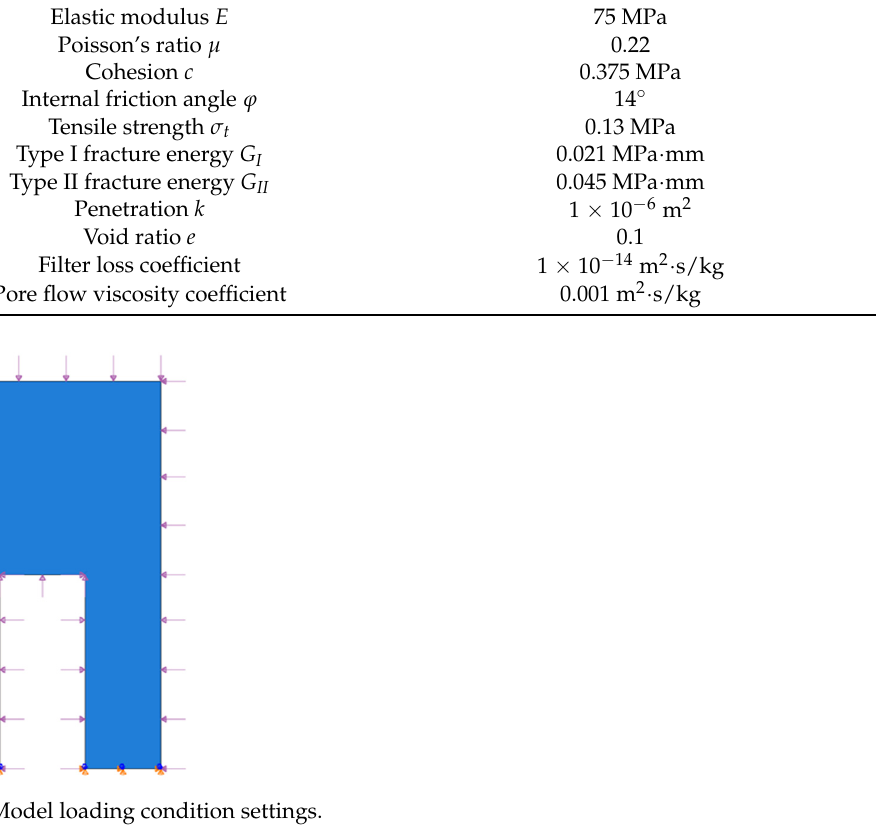
Figure 7. Injection point slurry pressure monitoring.